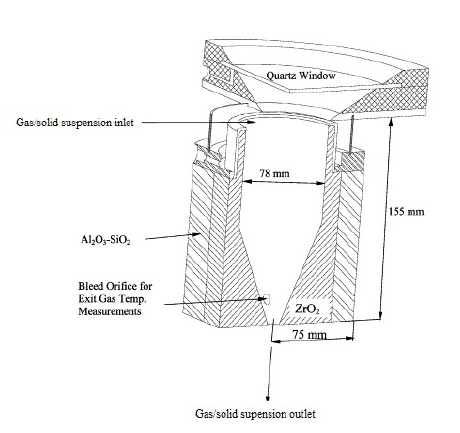
Figure 5. Volumetric reactor/receiver for solar cracking. Reprinted from [46] with permission from